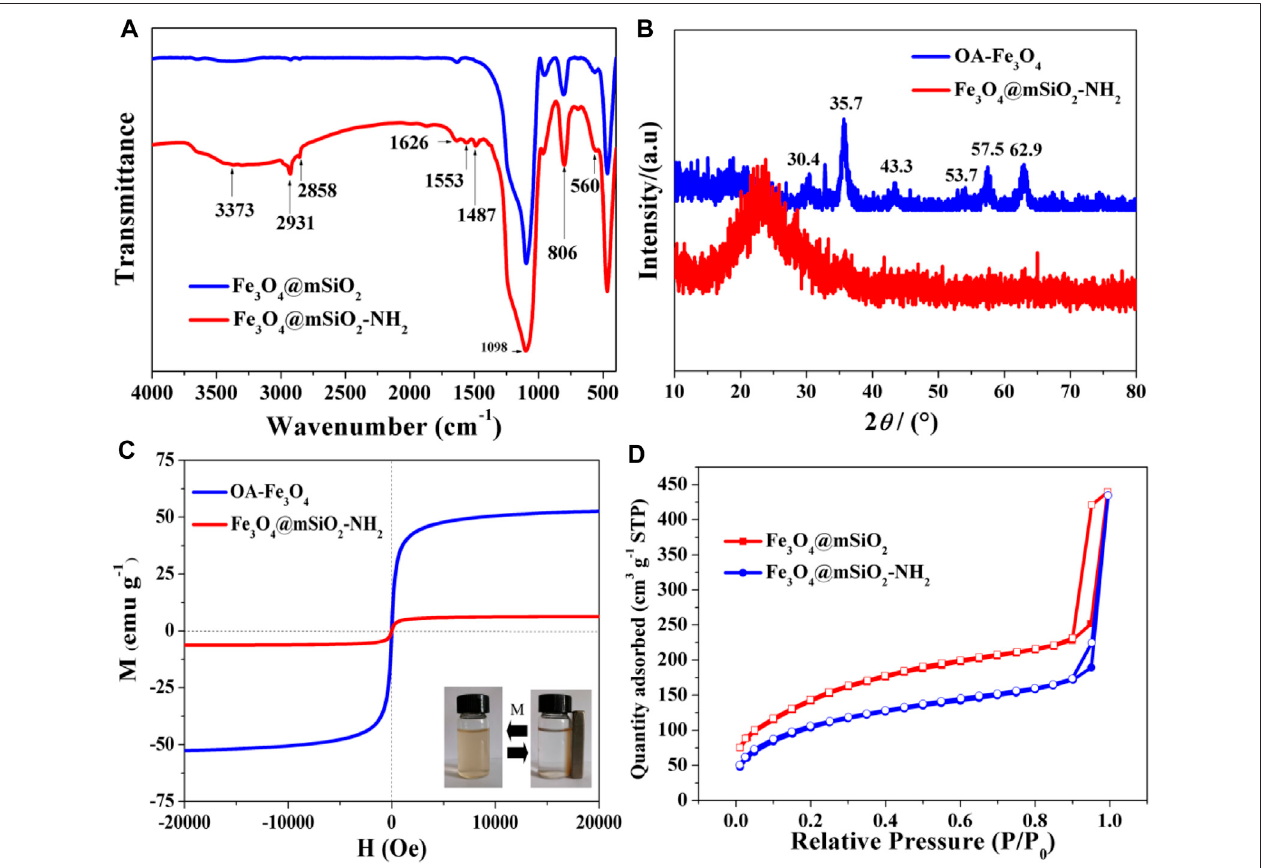
FIGURE 2 | (A) FT-IR spectra of Fe 3 O 4 @mSiO 2 NPs and Fe 3 O 4 @mSiO 2 -NH 2 NPs. (B) XRD patterns and (C) magnetic hysteresis loops of OA-Fe 3 O 4 NPs and Fe 3 O 4 @mSiO 2 -NH 2 NPs. The digital images are Fe 3 O 4 @mSiO 2 -NH 2 NPs that are dispersed in water and gathered by using a magnet. (D) N 2 adsorption isotherms of Fe